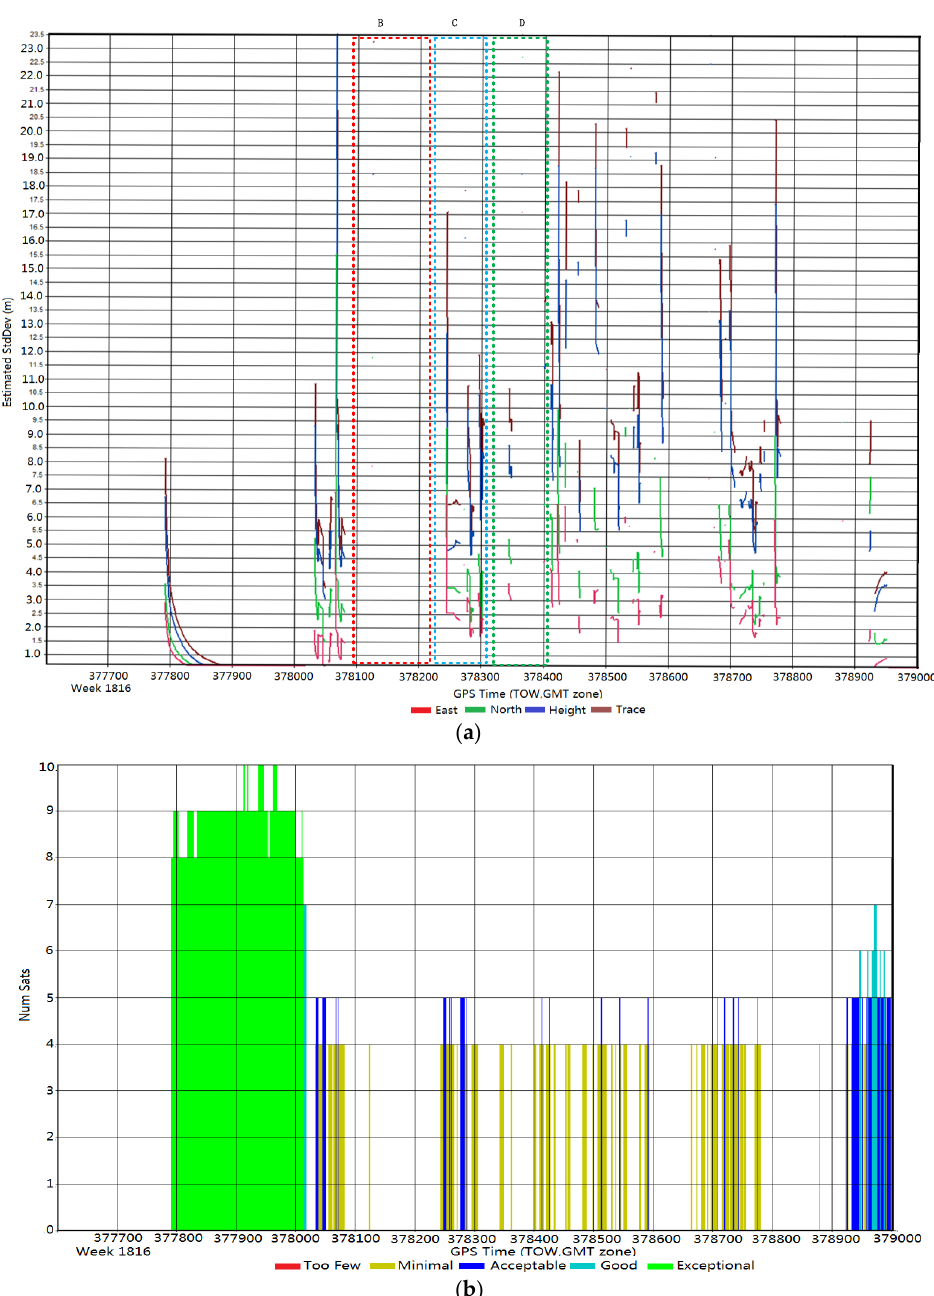
Figure 7. ( a ) Position accuracy and ( b ) satellite observability of the GNSS-only solution. Table 2. The accuracy of the trajectory in the EVO test site (Unit: m). RMSE (m)